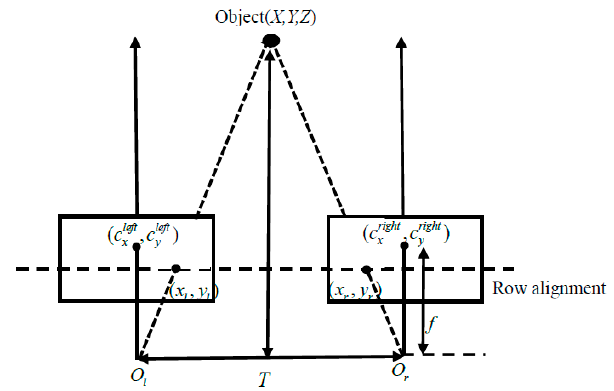
Figure 6. Binocular triangulation model.